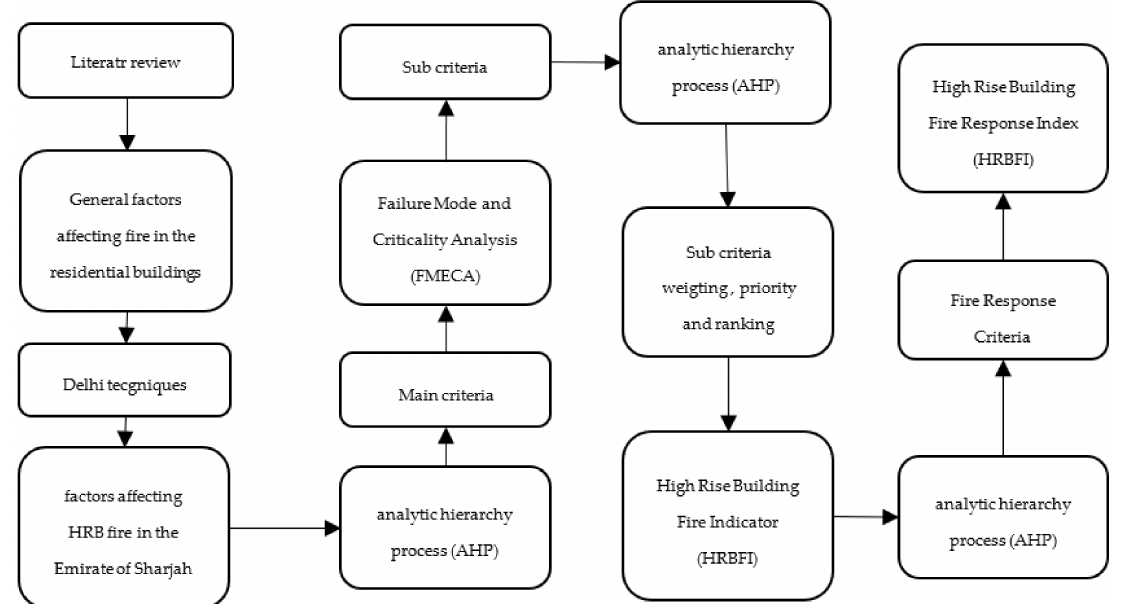
Figure 1. Methods of the